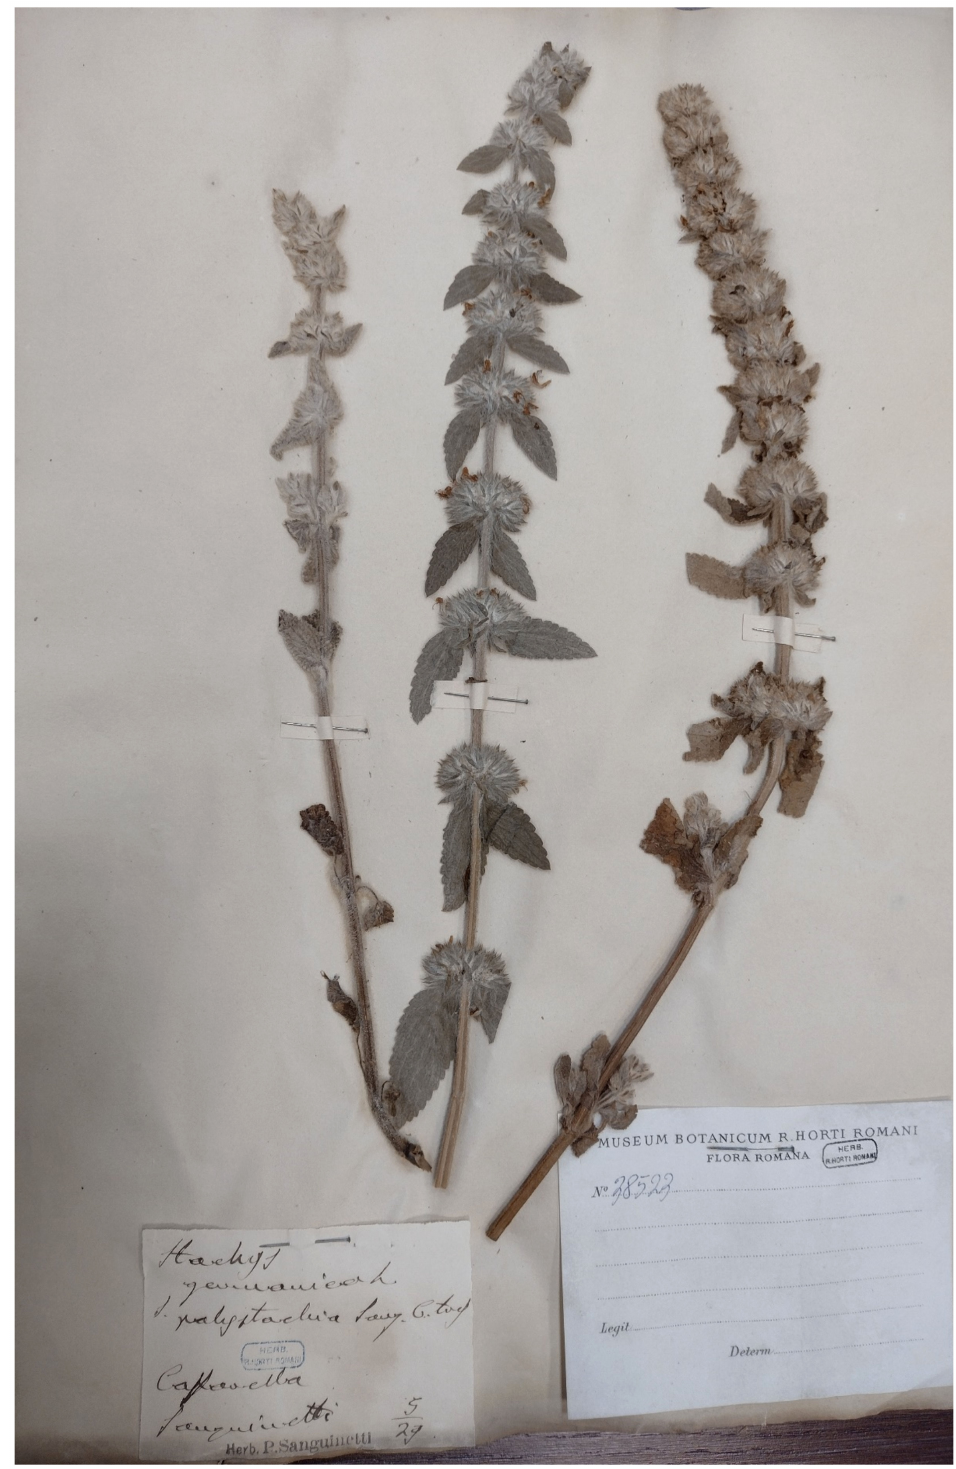
Figure 69. Specimen of Stachys germanica L. subsp. germanica collected in Caffarella valley in May 1829 (RO-Herbarium Romano no.